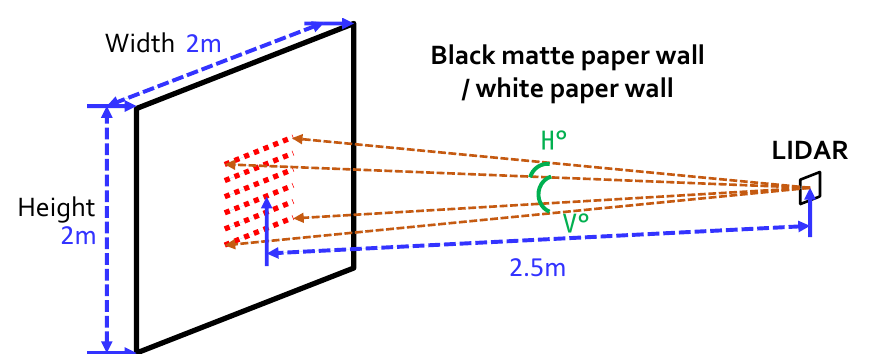
Figure 10. Environment used for the simulation of the proposed LIDAR